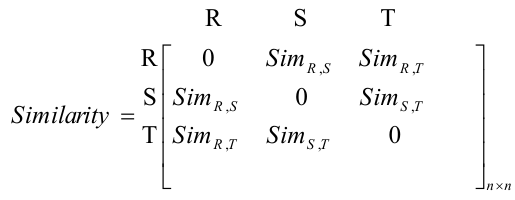
Figure 2. Relative similarity measure of the trajectories 2.3 Multi-dimensional Pattern Discovery based